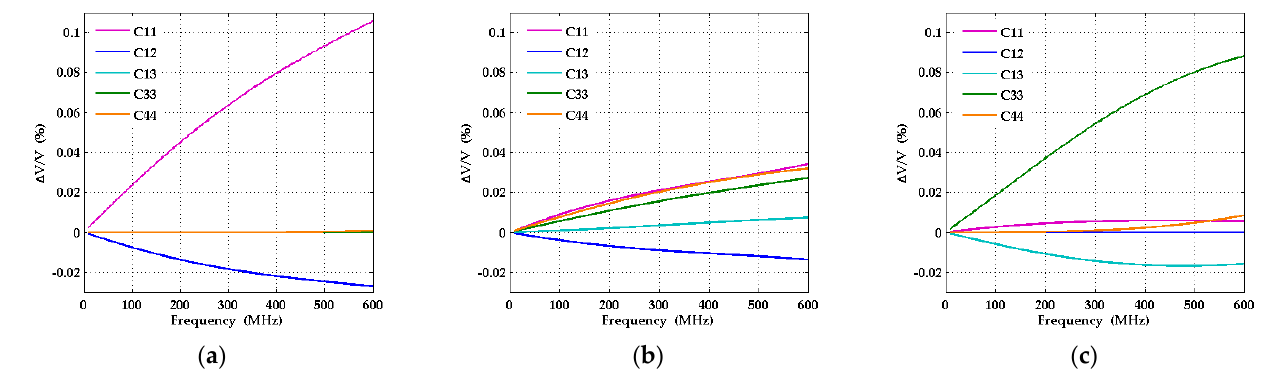
Figure 12. Relative change of phase velocity with 1% increase of elastic constants in the structure AlScN(11-20)/Al 2 O 3 (1-102) with 1000 nm thick Al 0.77 Sc 0.23 N film and 50 nm molybdenum film as function of frequency for the cases (a) θ = 0°; (b) θ = 45°; (c) θ = 90°.